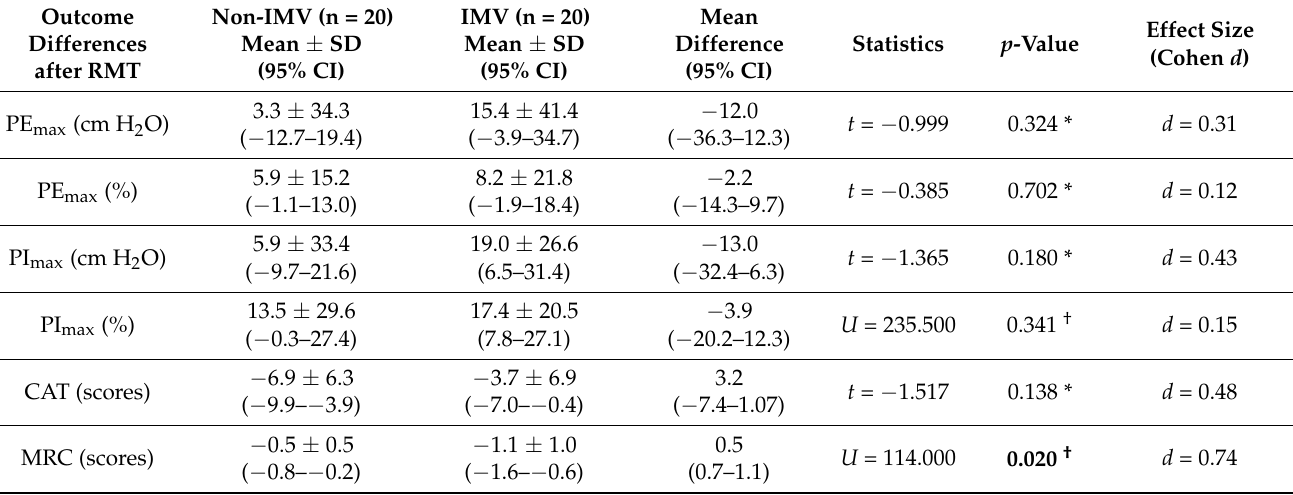
Table 6. Comparison of outcome measurement differences after RMT between non-IMV and IMV